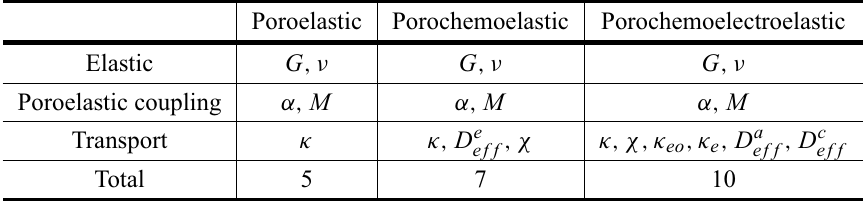
Material parameter characterizations for various poromechanics models.